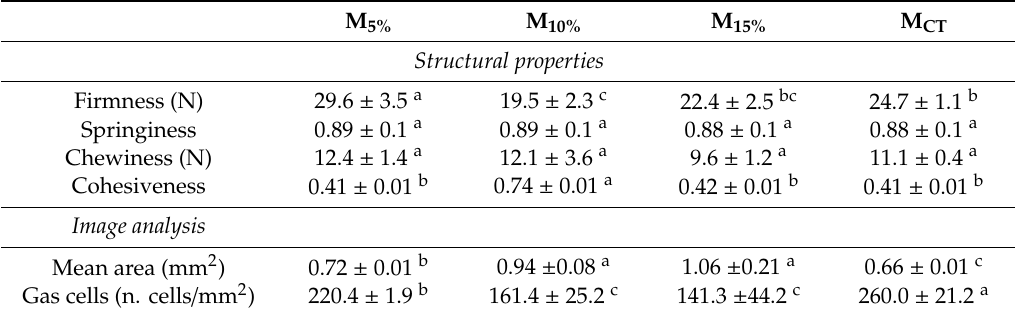
Table 5. Structural properties of the te ff mu ffi ns: M 5% , mu ffi n containing 5% (wt / wt) type-I